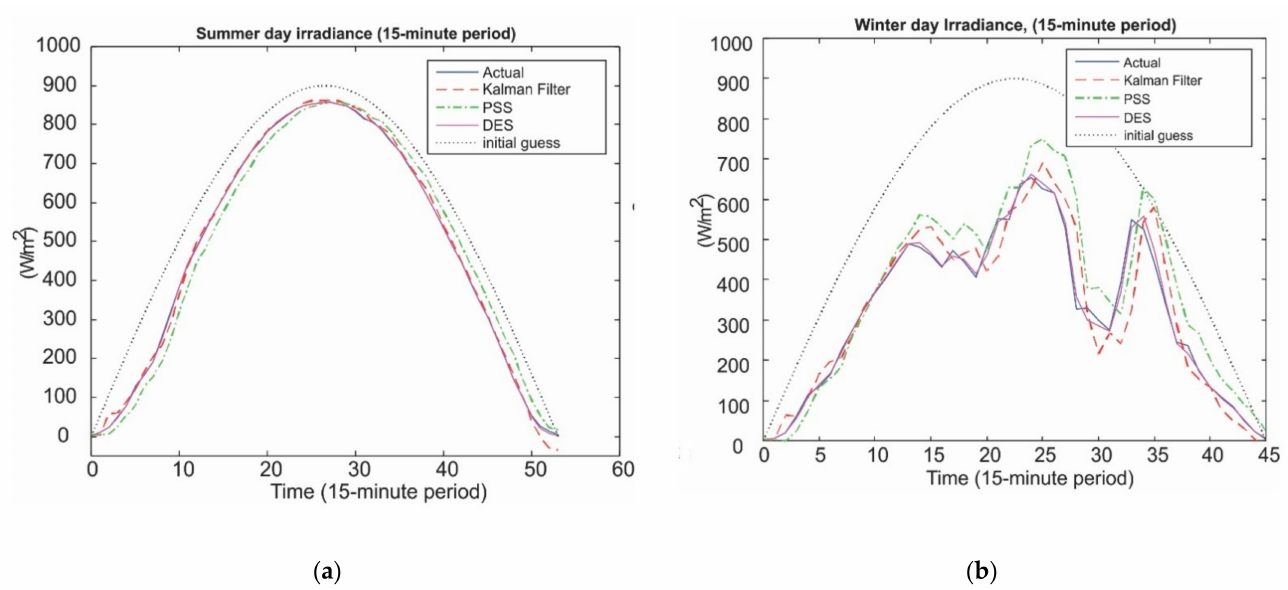
Figure 2. Solar irradiation prediction. ( a ) Summer day irradiance, ( b ) Winter day